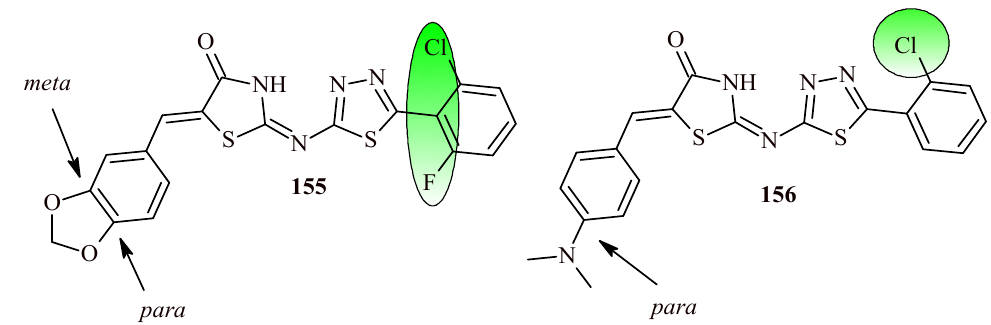
Figure 57. The structures of thiazolidin-4-one-1,3,4-thiadiazoles with activity against HCV.